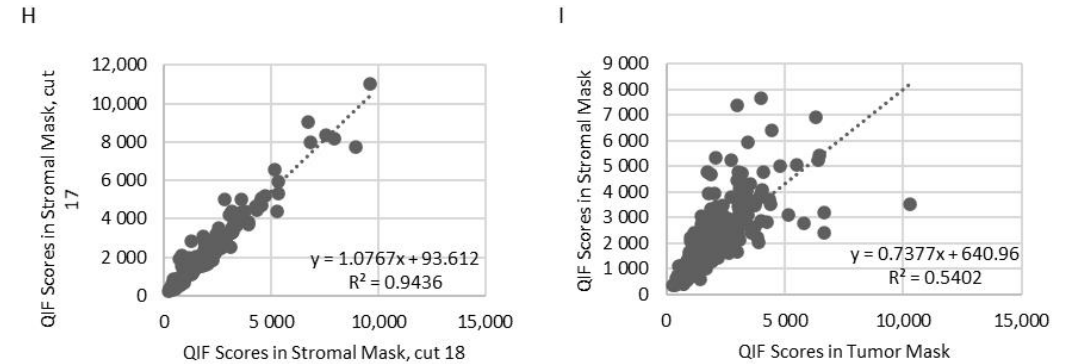
Figure 2. Patterns of expression and distribution of CD200R in lung cancer. ( A , B ) Dynamic range charts that depict CD200R expression within the stromal compartment in NSCLC ( A ) and LCNEC ( B ) patients. Red lines represent the visual cutoffs that were used to define CD200R positive cases. ( C – E ) Different cores from the same representative NSCLC case, stained in YTMA423 blocks 1 ( C ), 2 ( D ) and 3 ( E ). ( F – I ) Scatter plots indicative of intratumoral heterogeneity of CD200R in NSCLC. Scatter plots of YTMA423 block 1 versus block 2 ( F ) and block 3 ( G ). Scatter plot between serial cuts of YTMA423 block 1 ( H ). Scatter plot between tumor and stromal expression of CD200R on the same cut ( I ). Abbreviations; DAPI, 4 ′ ,6-diamino-2-phenylindole; CK, Cytokeratin.